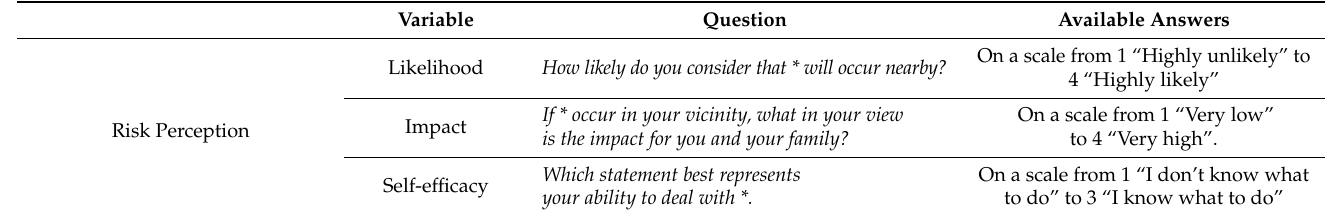
On a scale from 1 “Highly unlikely” to 4 “Highly likely”